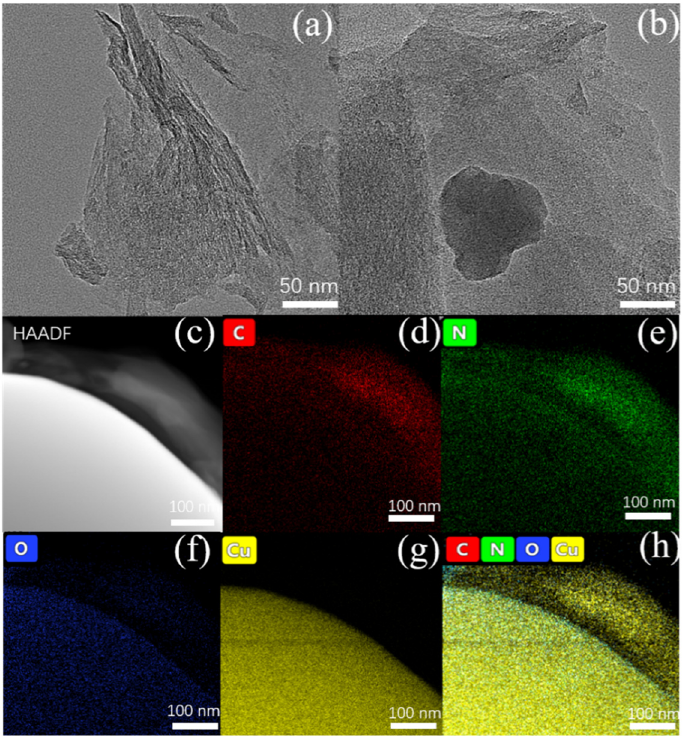
Figure 2. ( a , b ) TEM images of copper phthalocyanine after 900 °C temperature treatment. ( c–h ) HAADF image and the corresponding EDS Cu, O, C, and N mapping of copper phthalocyanine after 900 °C temperature treatment.